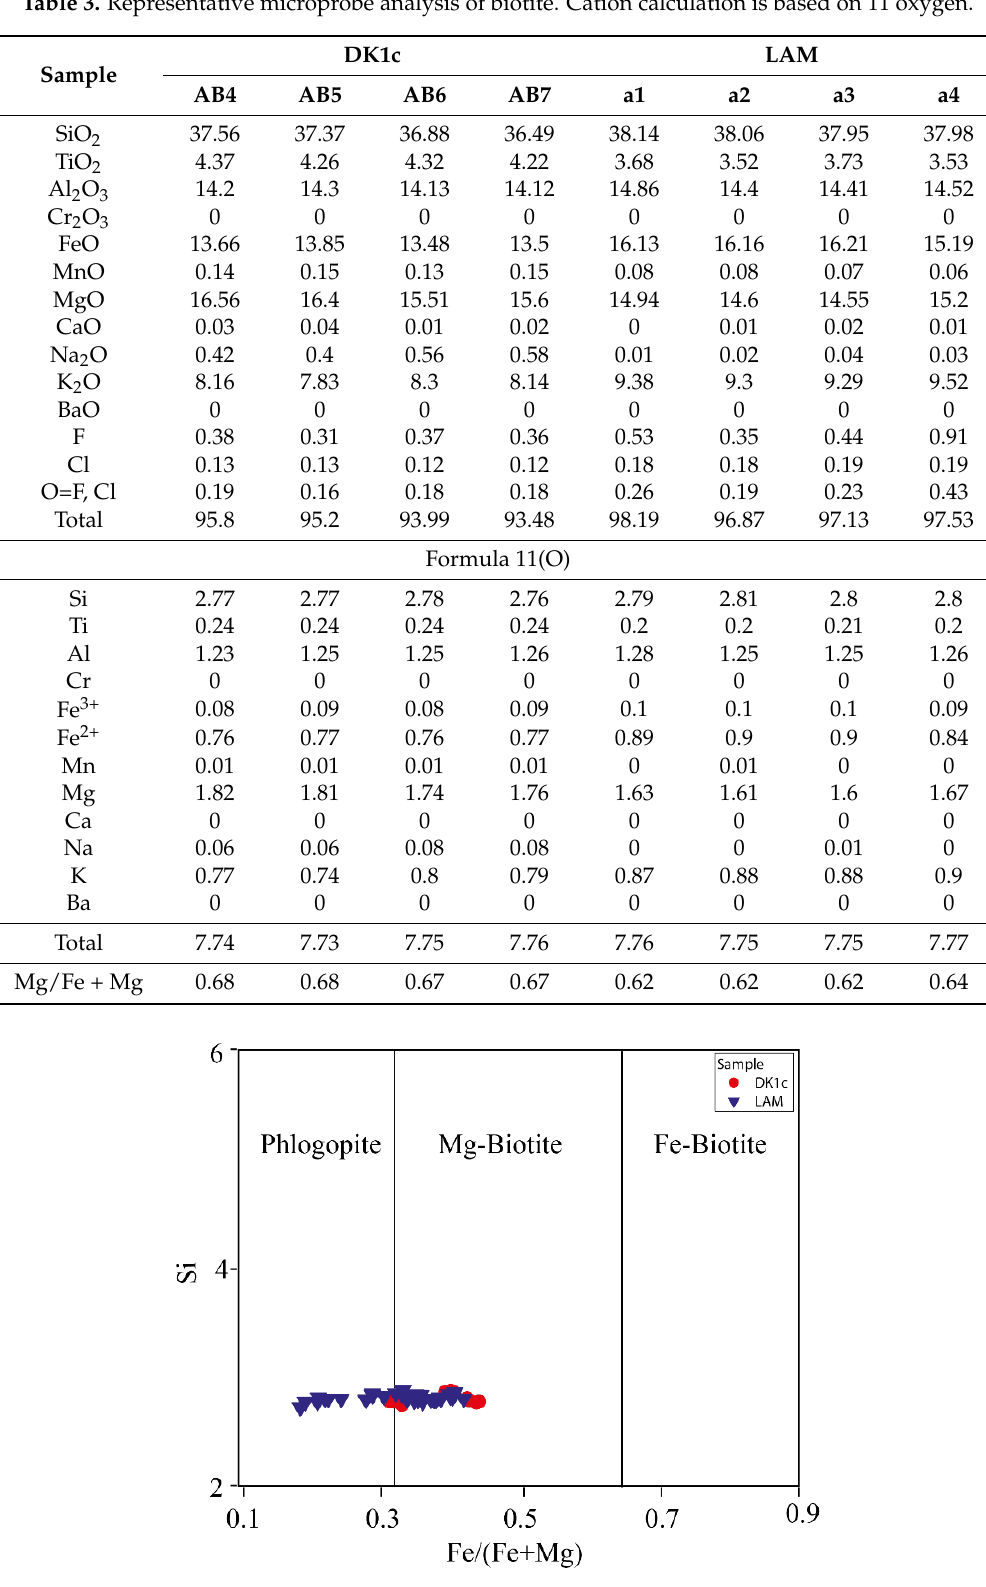
Figure 10. The classification of biotites from the dykes of the Sungun deposit [31,34]. Table 3. Representative microprobe analysis of biotite. Cation calculation is based on 11 oxygen. Sample